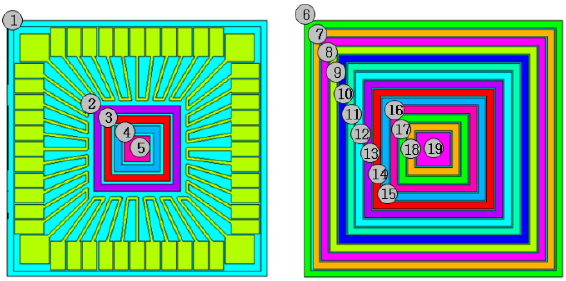
Figure 10. Dummy pattern setup for optimization by the HBGA.